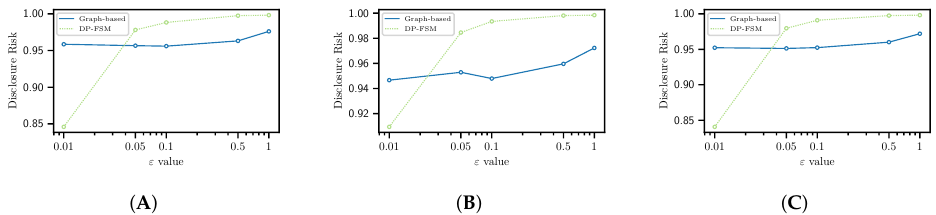
Figure 3. Disclosure risk measures’ comparison between the graph-based and DP-FSM algorithms. Where ( A ) is the Bank dataset, ( B ) is the German dataset, and ( C ) NYC dataset.